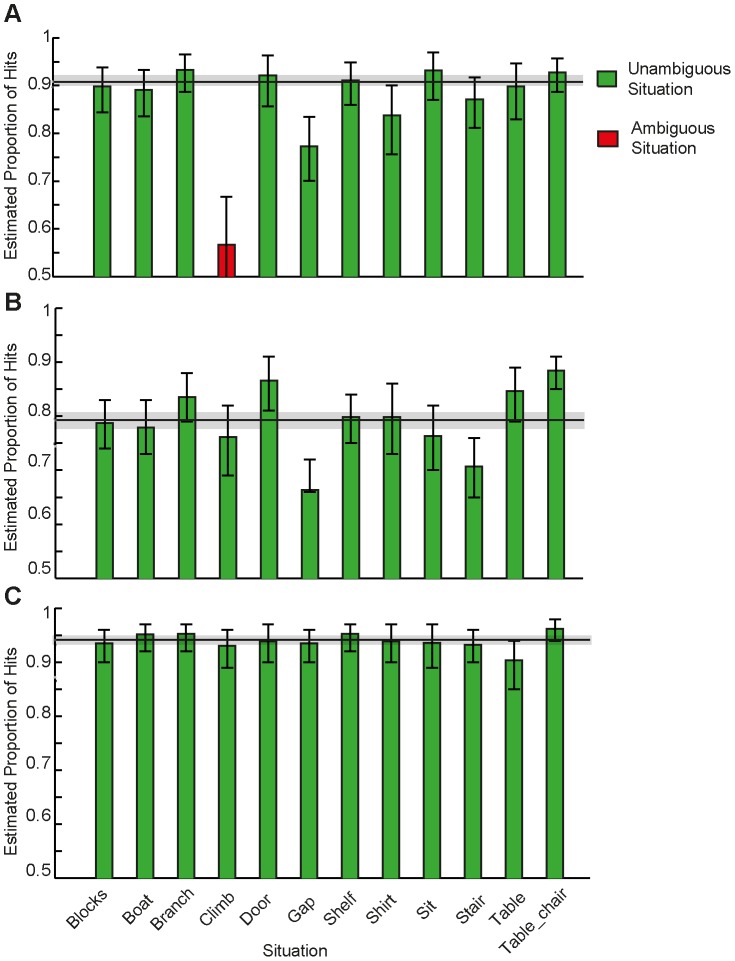
Estimated situation specific hit rates for P3-help-side (A), P2-help (B) and P1-bird (C).Estimates across variations of each situation are derived from tow-tailed exact binomial tests (π = .50). Green bars represent unambiguous situations (estimated hit rate significantly above .50) while red bars represent ambiguous situations (estimated hit rate not significantly different from chance). Error bars represent upper and lower bounds of the estimated hit rates' confidence intervals (CIs). Overall estimated hit rates were calculated across all unambiguous situations. Lines represent overall estimated hit rates, shaded areas surrounding them indicate their CIs.